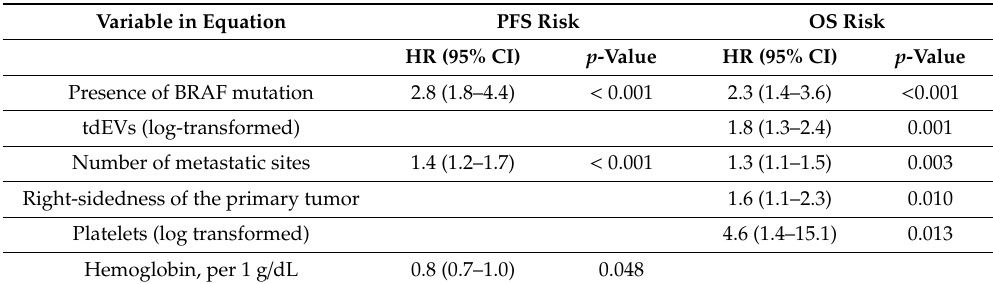
Table 2. Multivariable Cox proportional hazards regression analysis (using backward and forward stepwise